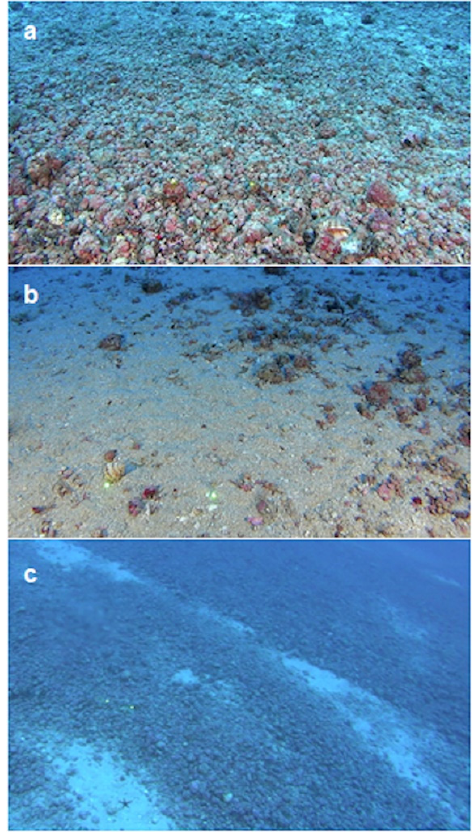
Figure 10. ( a ) Area characterized by high percent coverage of live rhodolith in S4; ( b ) area of rhodolith/maërl bed thinning in S1; ( c ) furrows probably left by trawling in S2.